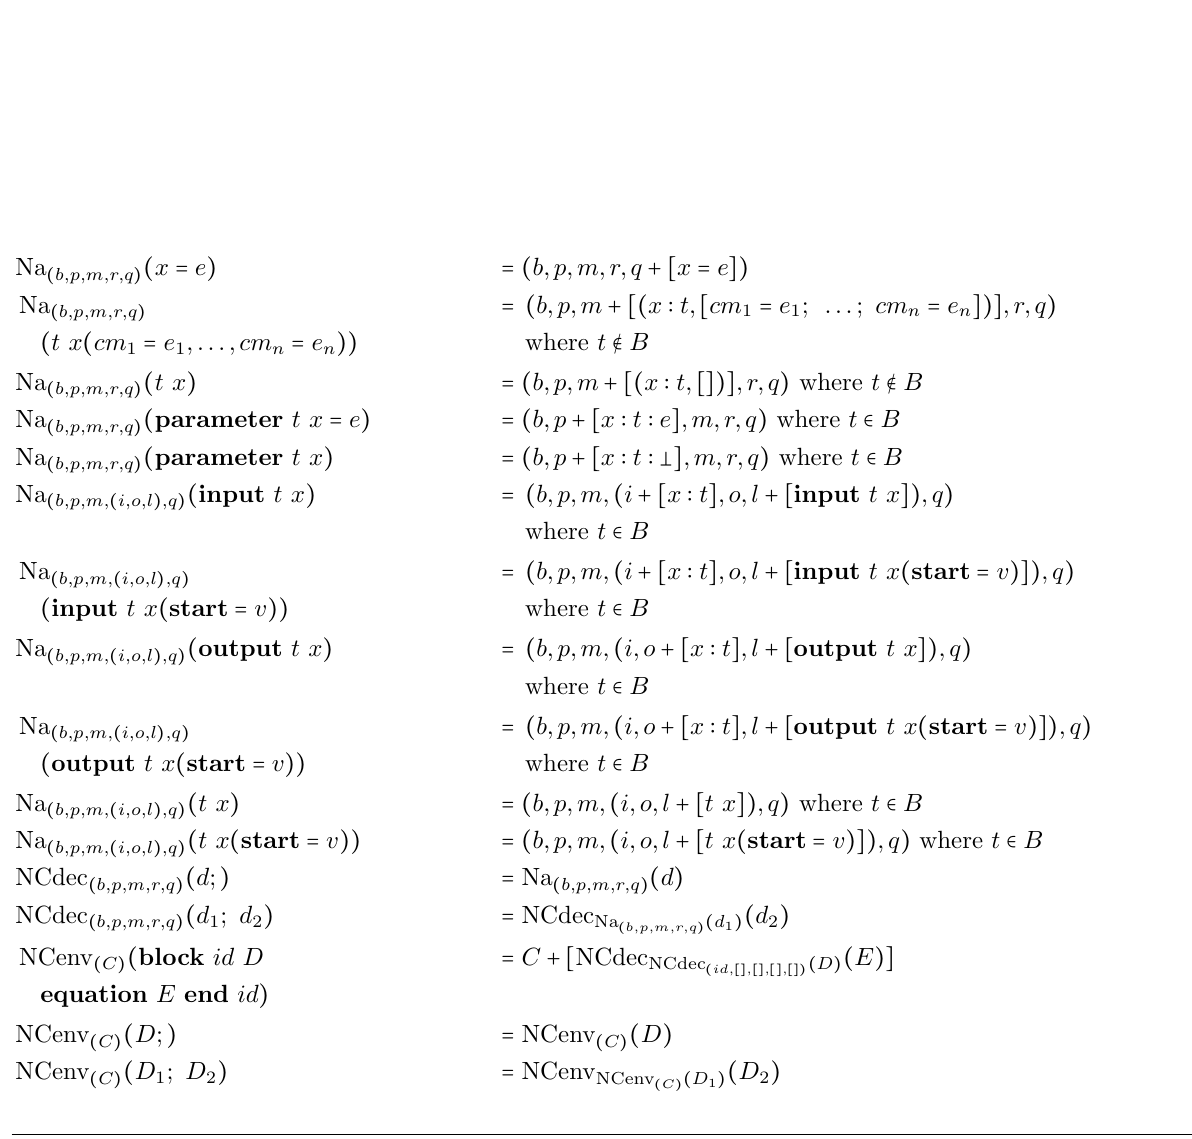
Figure 18: Function NCenv—Create an auxiliary representation structure for mACG-Modelica block declara-